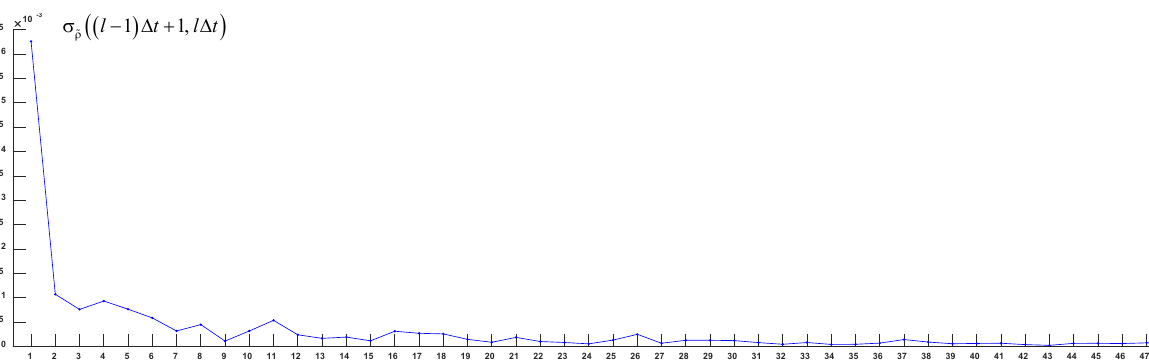
Fig. 4. Root-mean-square deviations (13) for the example in Fig. 3. The moving deviations quickly decrease similarly to those in Fig. 2, although not strictly.